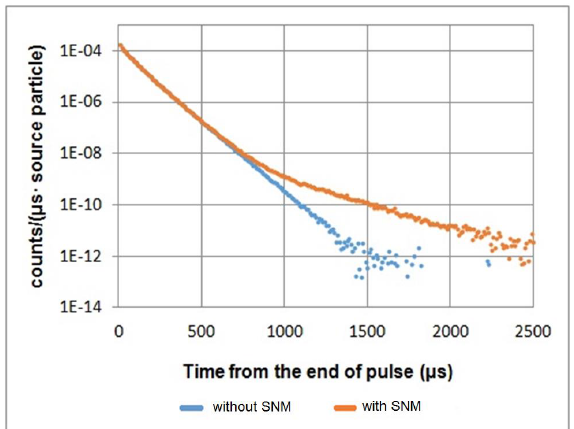
Figure 3. Simulated signals collected by the Neutron Active Interrogation (NAI) device of samples containing (red dots) and not containing (blue dots) Special Nuclear Materials fissile material.